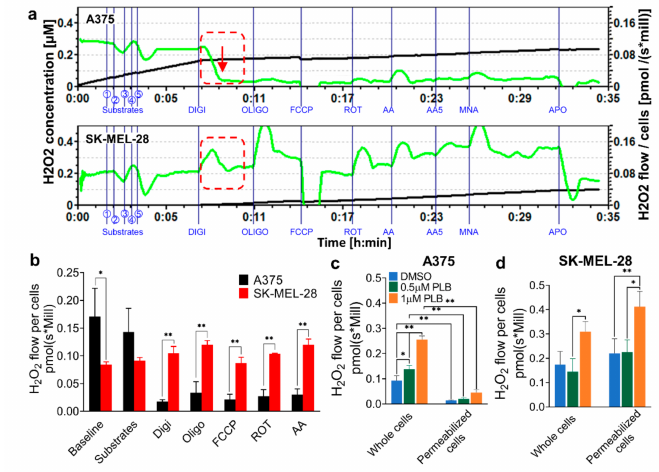
Figure 2. H 2 O 2 production rate for whole and permeabilized melanoma cells at basal and PLB induced levels. A375 and SK-MEL-28 cells were counted and placed in the Oroboros respiratory chambers, with sequential injections of Cx I and Cx II substrates ( 1 (cid:13) L-glutamate; 2 (cid:13) L-malic; 3 (cid:13) ADP; 4 (cid:13) pyruvate; 5 (cid:13) succinate), Digi (8.1 mM), Oligo (5 mM), FCCP (1 mM), ROT (1 mM), and AA (5 mM). H 2 O 2 signals were detected by Amplex UltraRed. ( a ) The H 2 O 2 level (black line) and H 2 O 2 flow for per million A375 and SK-MEL-28 cells (green line) were monitored in real-time. The red dashed box, along with a red arrow, highlights the H 2 O 2 production drop in A375 cells compared to SK-MEL-28 cells. ( b ) The stable H 2 O 2 flow values for per million A375 and SK-MEL-28 cells are displayed in the bar graph. ( n = 3) The H 2 O 2 production rates for whole and permeabilized ( c ) A375 cells and ( d ) SK-MEL-28 cells with DMSO and 1 and 3 µ M PLB treatments are represented as the H 2 O 2 flow before and after digitonin is applied ( n = 3). Results are expressed as mean ± SD. * p < 0.05, ** p < 0.01. DMSO, dimethyl sulfoxide; PLB, plumbagin.